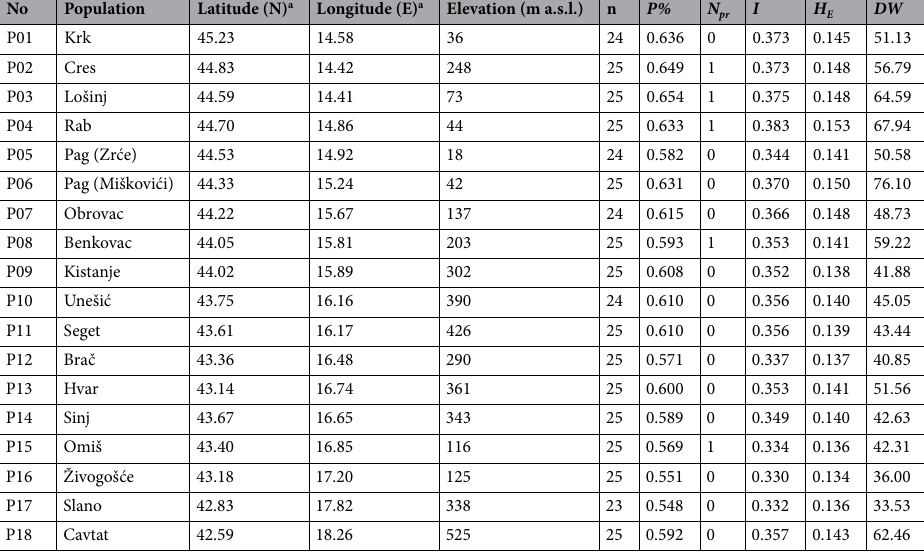
Table 1. Sampling locations and genetic diversity revealed by AFLP markers in 18 H. italicum populations from eastern Adriatic coast. a N-North; E-East; Coordinates are in degree decimal format; n - sample size; %P - proportion of polymorphic bands; Npr - number of private bands; I - Shannon’s information index; H E - gene diversity of population assuming Hardy-Weinberg equilibrium; DW - frequency down-weighted marker